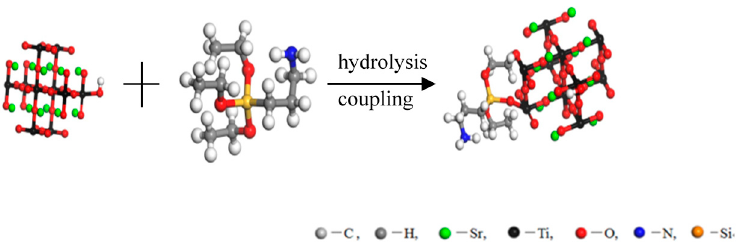
Figure 1. Schematic of the surface treatment of SrTiO 3 nanoparticles.